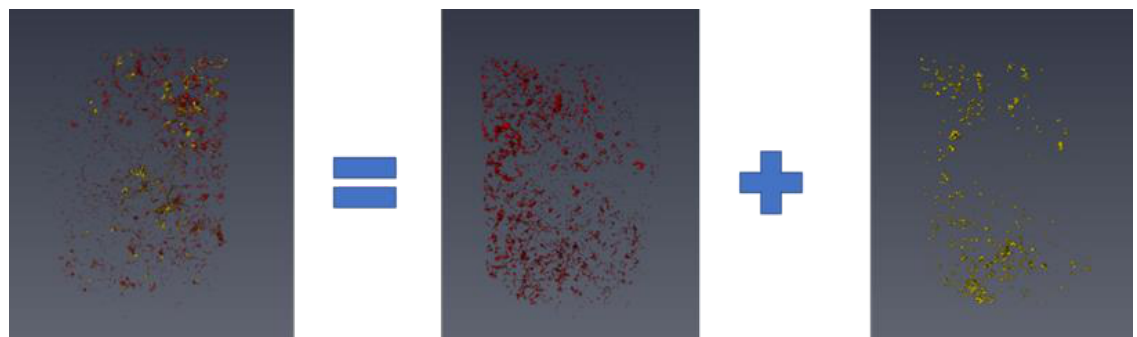
Figure 20. Y56 – 19 core after CO 2 flooding (red is the distribution of crude oil and yellow is the injected CO 2 ).